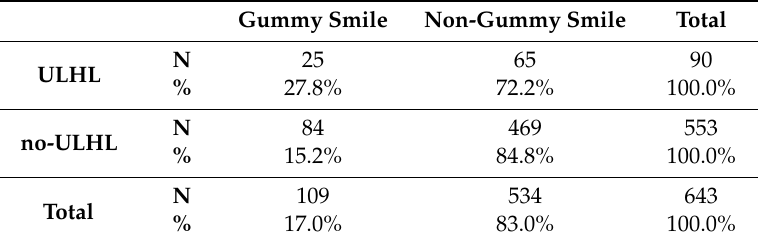
Table 3. The prevalence of the ULHL and without it (no-ULHL) according to a gummy smile. Based on the Chi-square analysis, a significant di ff erence ( p = 0.004) was found in the prevalence of ULHL in the presence of a gummy smile.